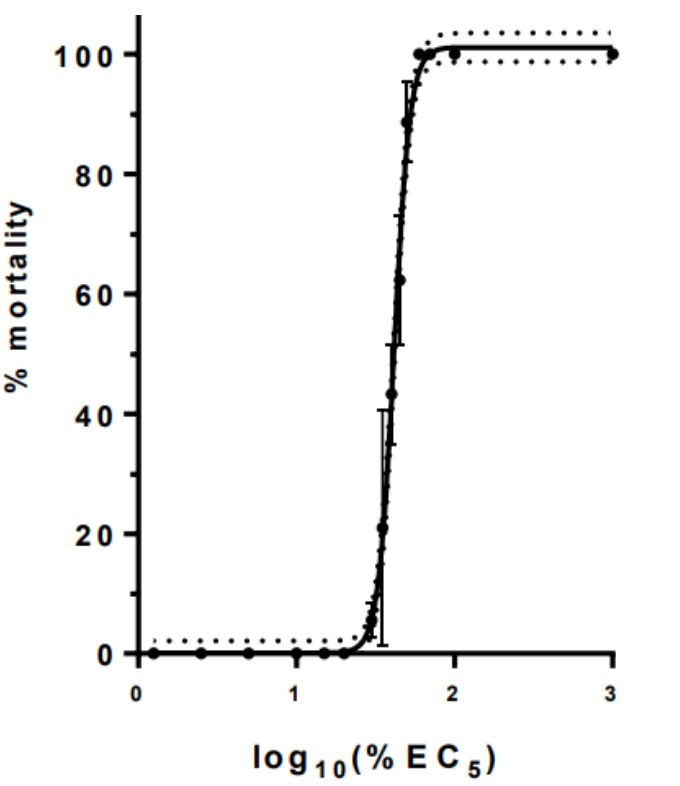
Figure 3. Acute toxicity curve of composite mixture of chemicals. Data represent average ± standard deviation (N = 6 replicates).